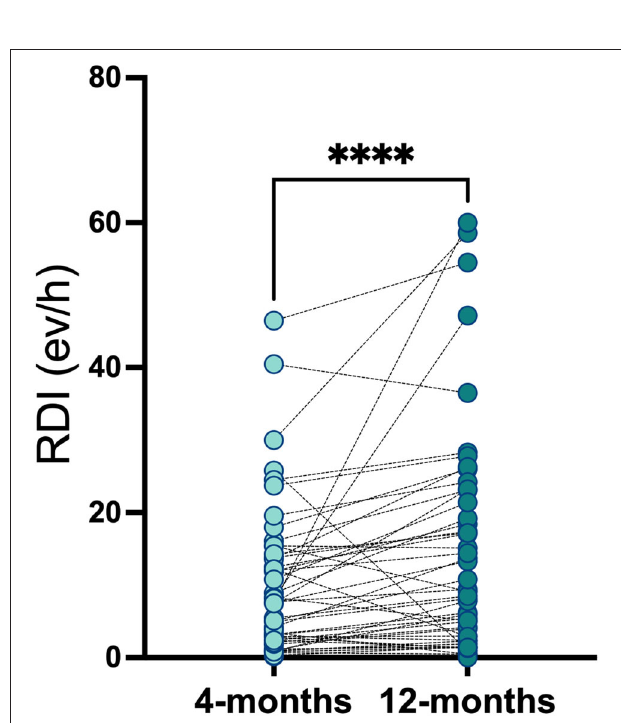
FIGURE 3 | Respiratory disturbance index in OSA and non-OSA patient groups at 4-months and 12-months after COVID-19 infection. Respiratory disturbance index was measured in OSA and non-OSA at 4-months (Visit_1) and 12-months (Visit_2) after COVID-19 infection. Wilcoxon matched-pairs signed rank test was used and **** p < 0.0001.